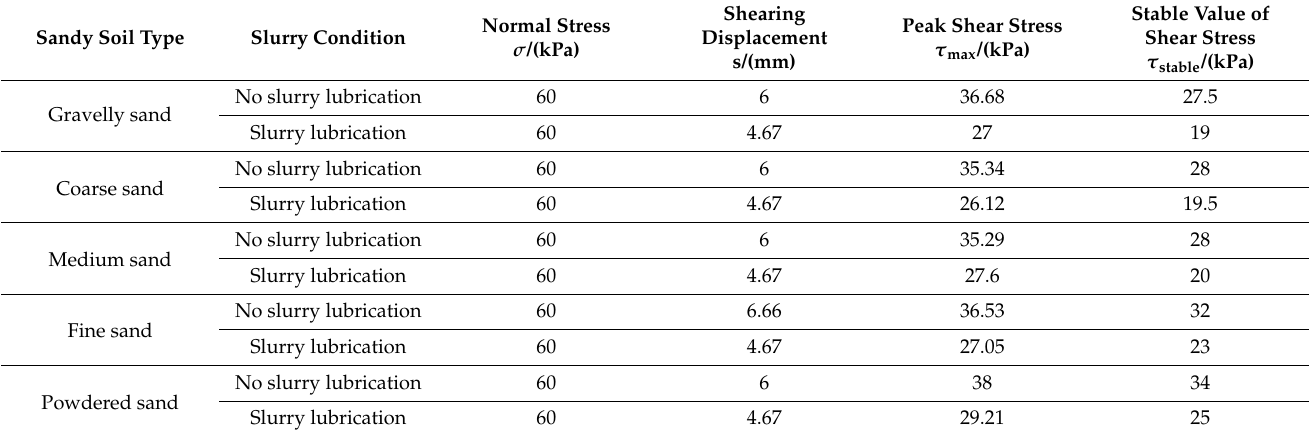
Table 1. Shear stress peak and stable value of sand interface under different lubrication conditions.